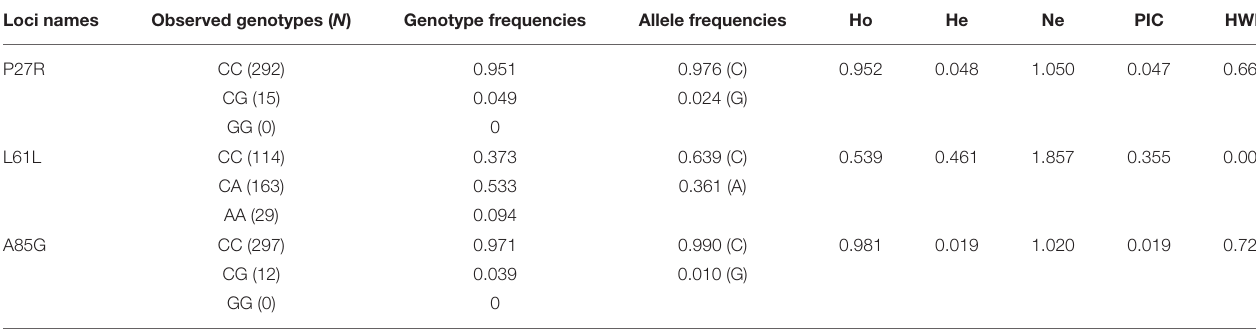
TABLE 2 | Genotypic and allelic frequencies of seven SNPs within the GDF9 gene in Shaanbei white cashmere (SBWC)